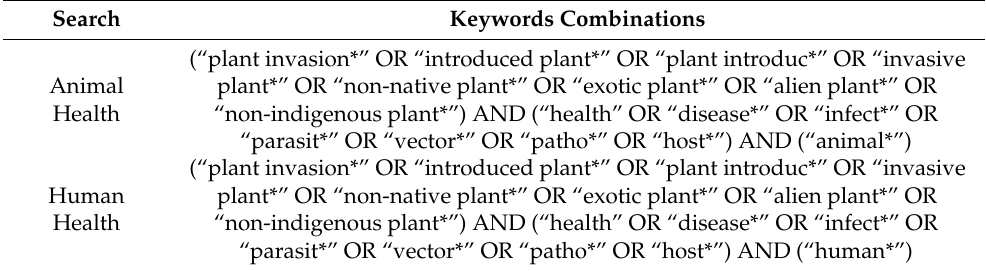
Table 2. Terms combination applied in two separate searches to refine results, both in Web of Science and Scopus